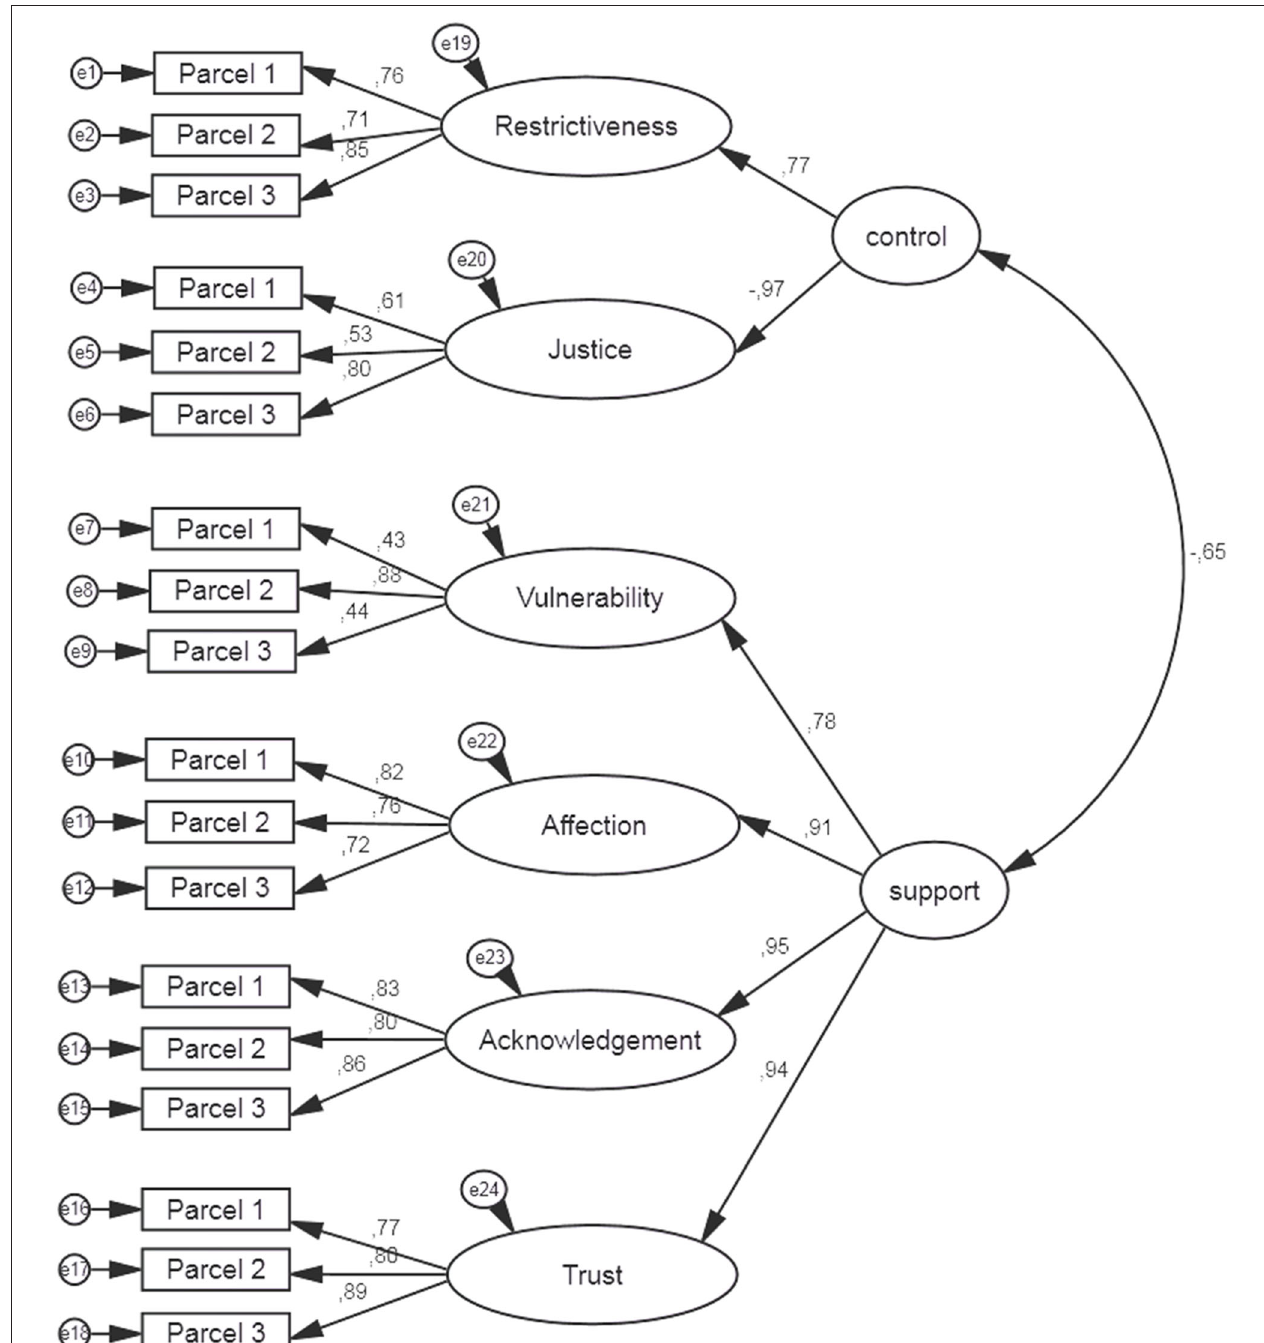
FIGURE 3 | CFA model for the child-father dyad in the